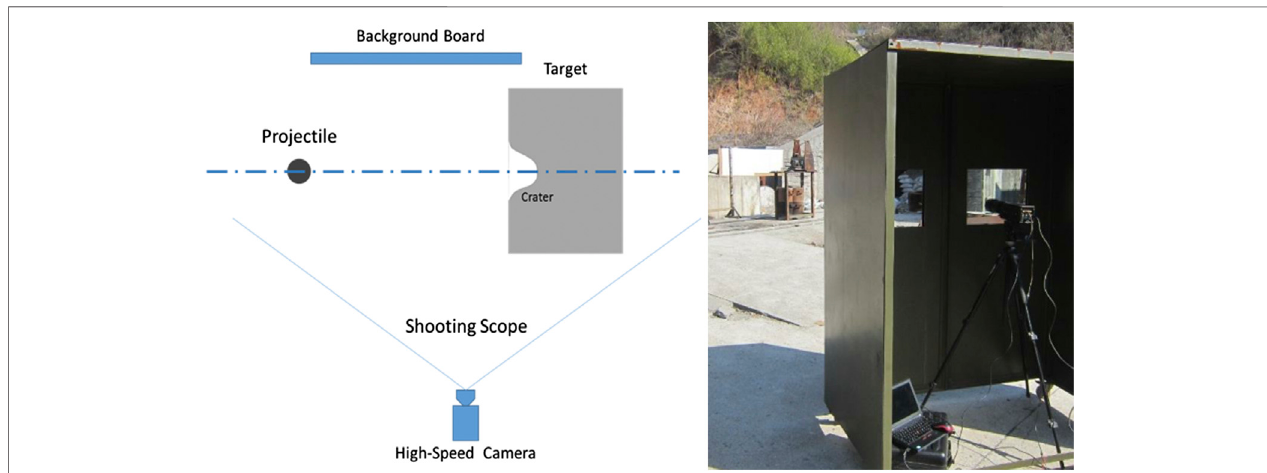
FIGURE 4 | The layout of high-speed camera